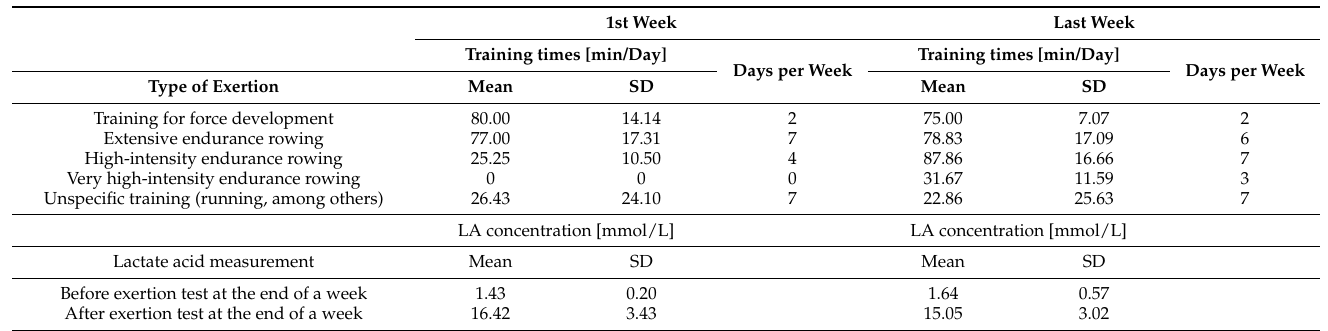
Table 1. Distribution of increasing training load over the course of training and the value of lactic acid (LA) in the study group before and after the exertion